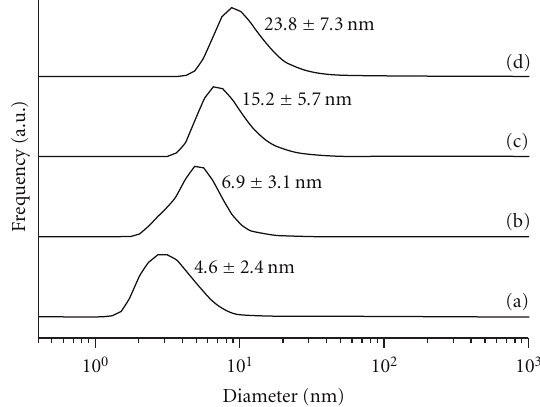
Figure 4: Volume-average particle size distributions of 2.0 w/v% aqueous dispersions of SQ/ZrO 2 -NPs measured by DLS at 25 ◦ C. Feed molar ratio of APTMOS/ZTB = (a) 0.3, (b) 0.6, (c) 0.8, and (d) 1.0.